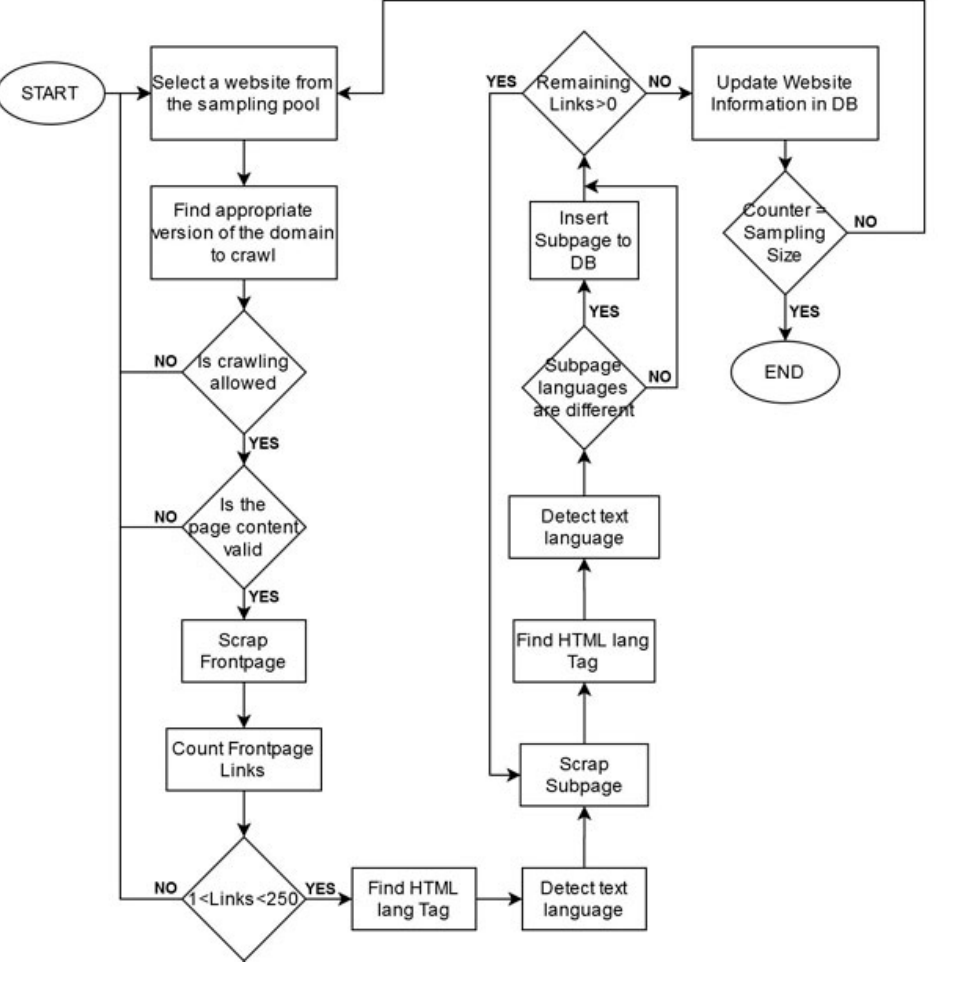
Figure 2. Flowchart of the crawling